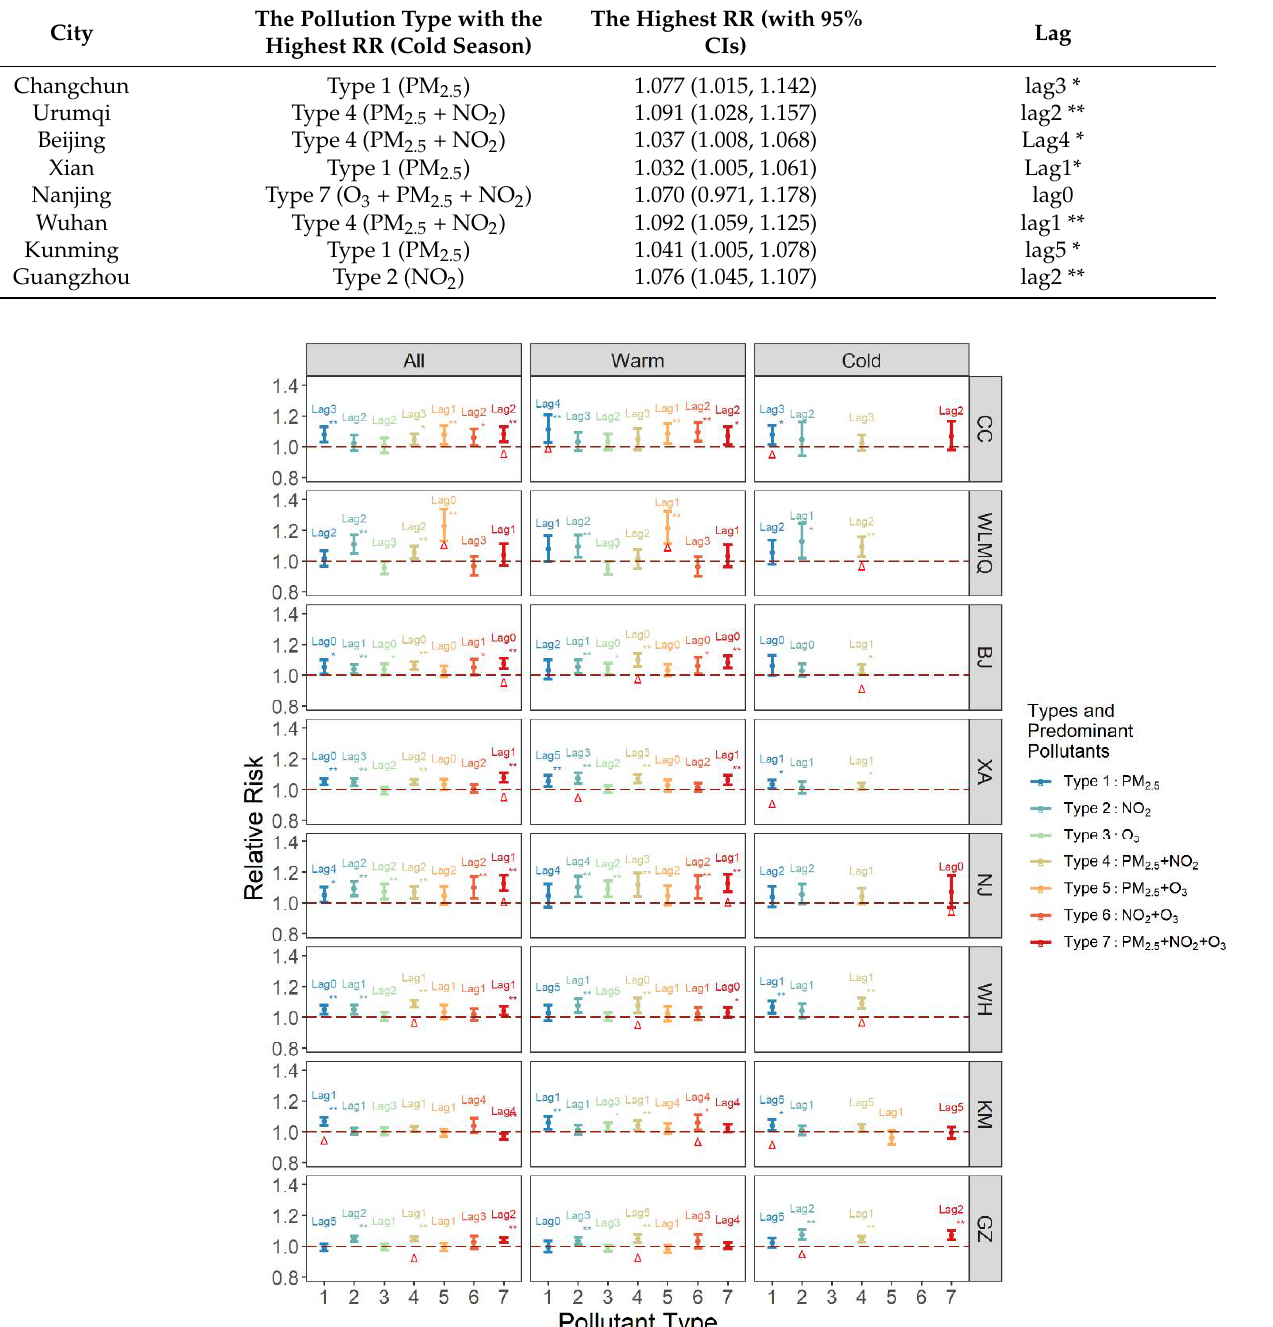
Table 6. The pollution type with the highest lag of 0–5 days and their corresponding risk values and lag days in 8 cities. Pollutants at high levels are listed in parentheses (Cold Season). * p < 0.05, ** p < 0.01.